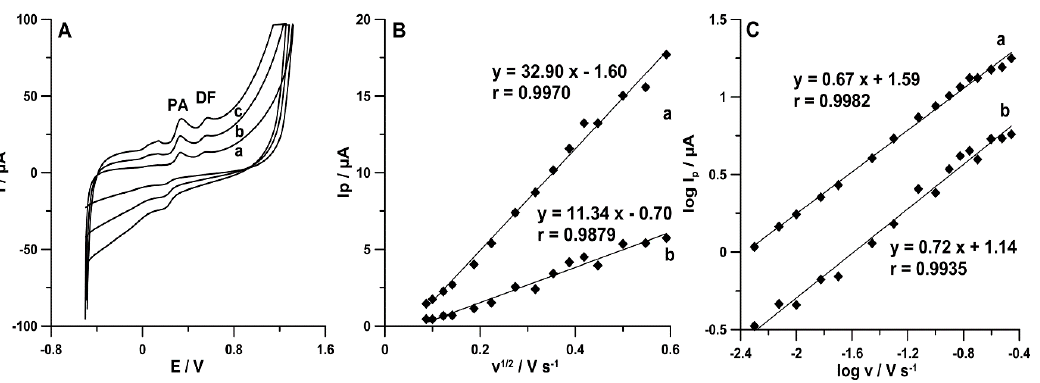
Figure 6. ( A ) CV curves recorded in the 0.15 mol L − 1 acetate buffer solution of pH 4.0 containing 1.0 × 10 − 4 mol L − 1 PA and 1.0 × 10 − 6 mol L − 1 DF at v equal to (a) 50, (b) 100, and (c) 175 mV s − 1 . The dependence between ( B ) Ip and v 1/2 and ( C ) log Ip and log v for PA (a) and DF (b).